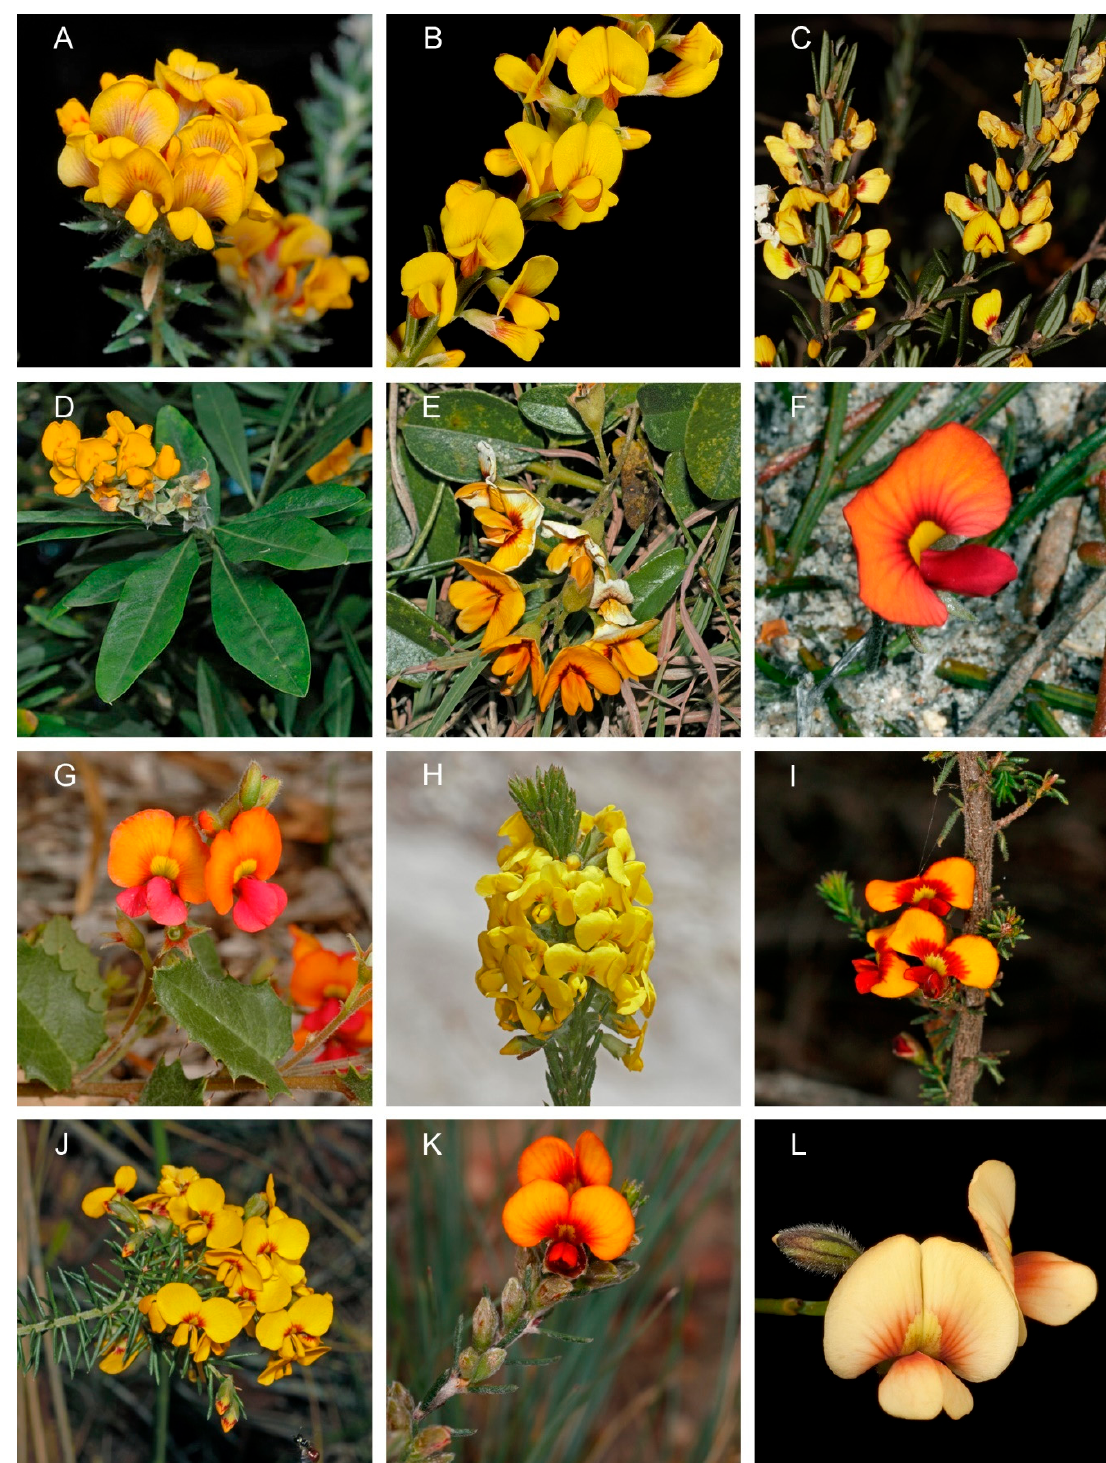
Figure 3. Morphological diversity of representative species from Fabaceae tribe Mirbelieae (core Mirbelieae). ( A ) Almaleea incurva. ( B ) Aotus gracillima . ( C ) Aotus lanigera . ( D ) Callistachys lanceolata . ( E ) Callistachys scandens . ( F ) Chorizema rhombeum . ( G ) Chorizema varium . ( H ) Dillwynia ericifolia . ( I ) Dillwynia phylicoides . ( J ) Dillwynia retorta . ( K ) Dillwynia sericea . ( L ) Erichsenia uncinata . Photographs by Russell Barrett except ( A , D , G ) by Murray Fagg and ( B , L ) by Kevin Thiele (( A , B , D , G , L ) from the Australian Plant Image Index: http://www.anbg.gov.au/photo (accessed on 11 June 2021)).